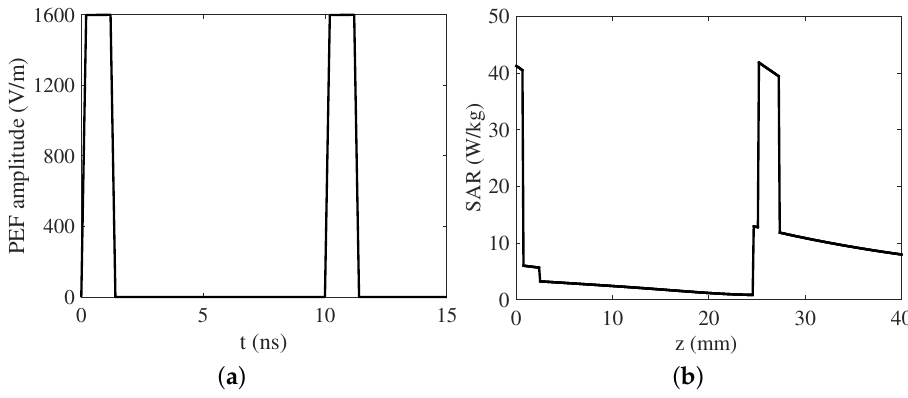
Figure 4. ( a ) PEF source having E max = 1600 V/m and t hold = 1 ns; ( b ) the corresponding SAR profile inside the multilayered head